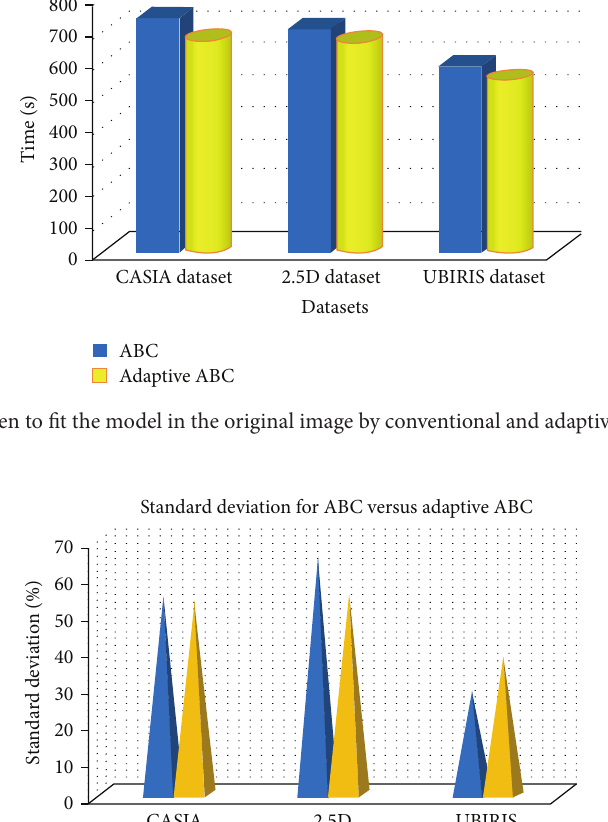
to the performance over the other rounds of the